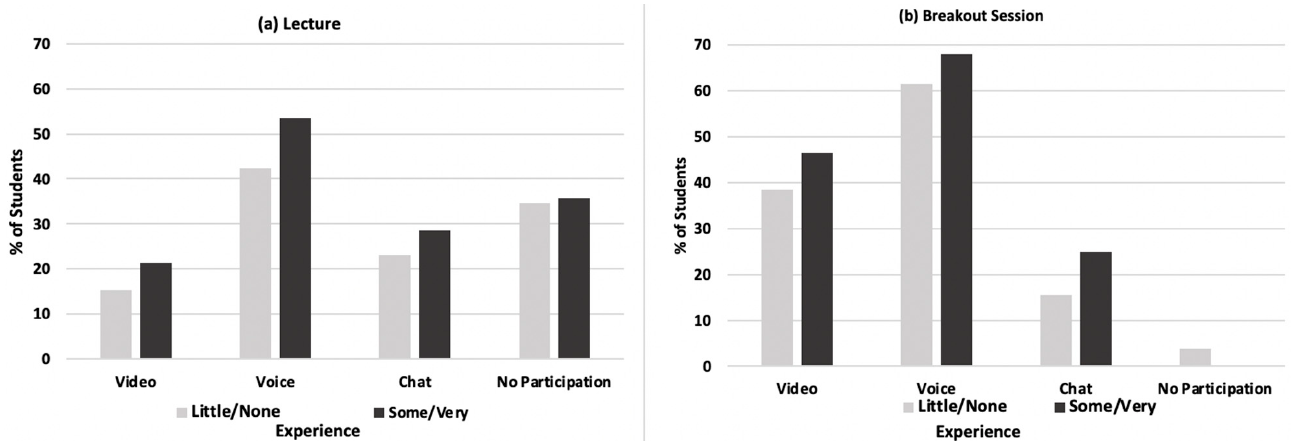
Figure 2. Comparisons of methods of communication used during ( a ) lecture and ( b ) breakout sessions by experience with videoconferencing before March 2020. Comparisons performed with independent t -tests.